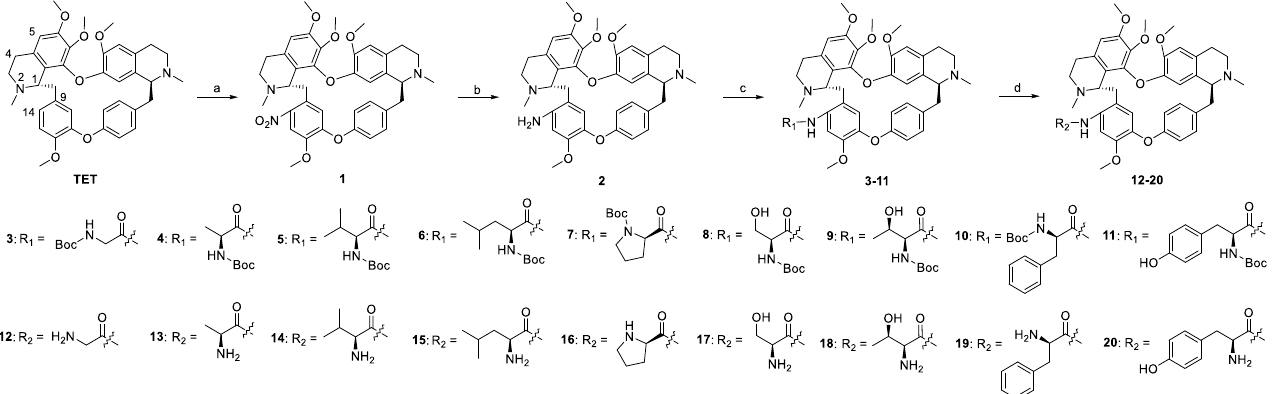
Figure 1. Design strategy of amino acid derivatives of